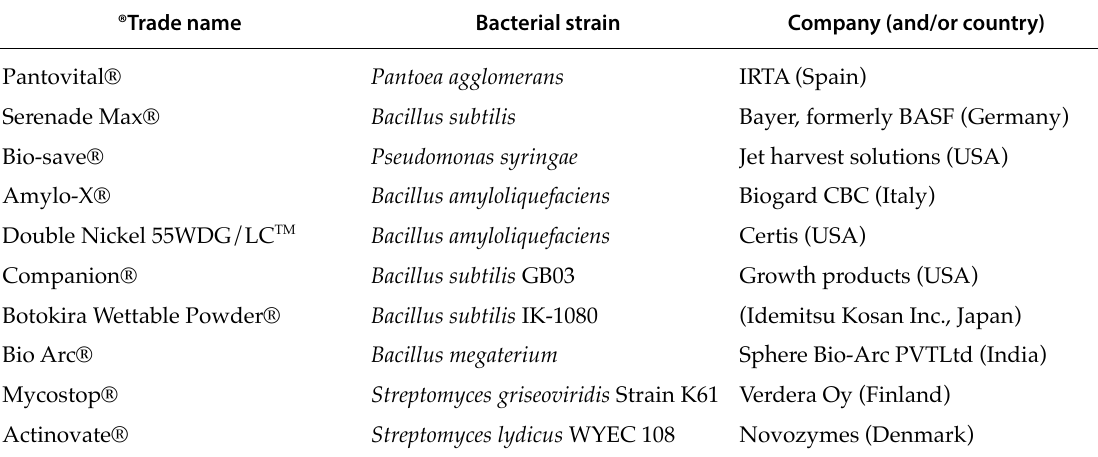
Table 1. Commercially available biopesticides based on bacteria, for control of gray mold on different